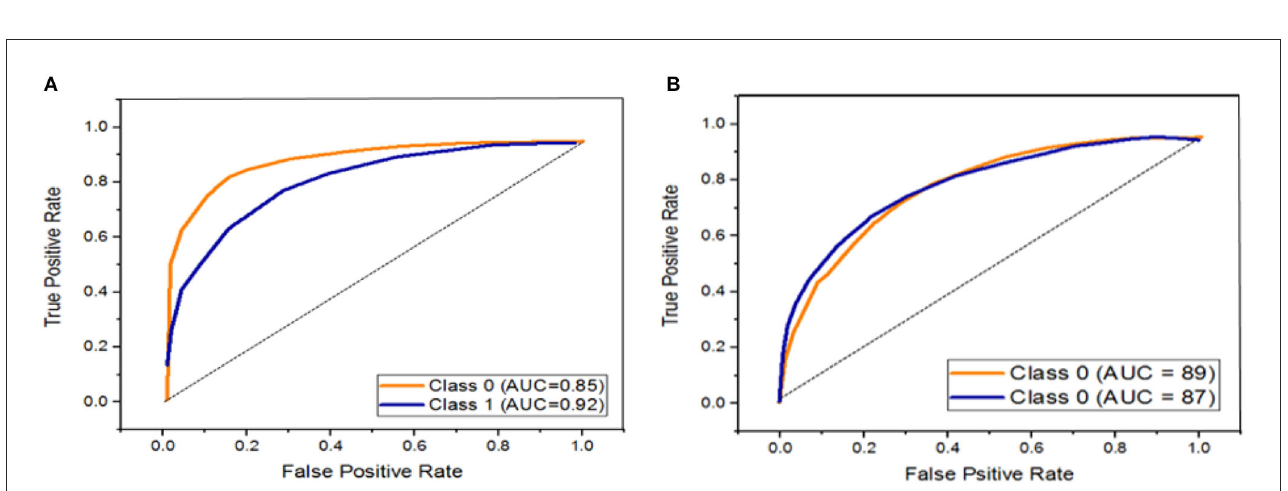
FIGURE6 ROC curves for Inception V3 and VGG-16. (A) Representing the ROC by using Inception V3 and (B) representing the ROC by using